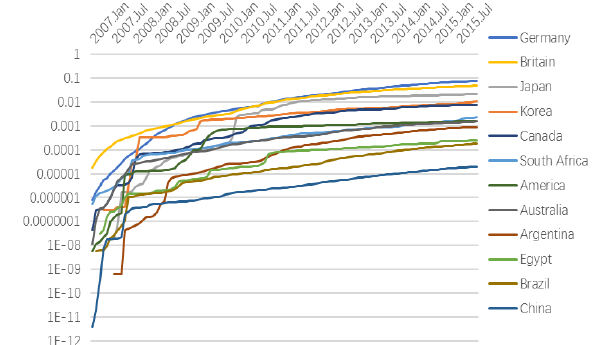
Figure 2. Number of OpenStreetMap (OSM) Nodes per Population/Area-ratio (Jan. 2007–Dec. 2015)